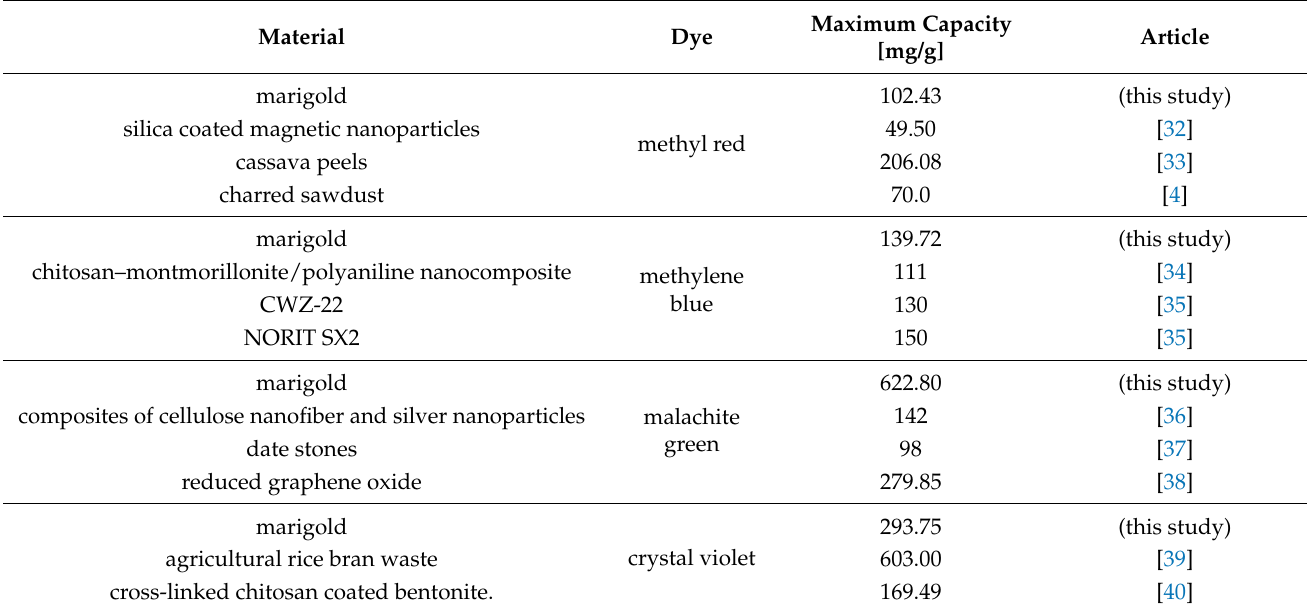
Table 7. Adsorption capacity of selected